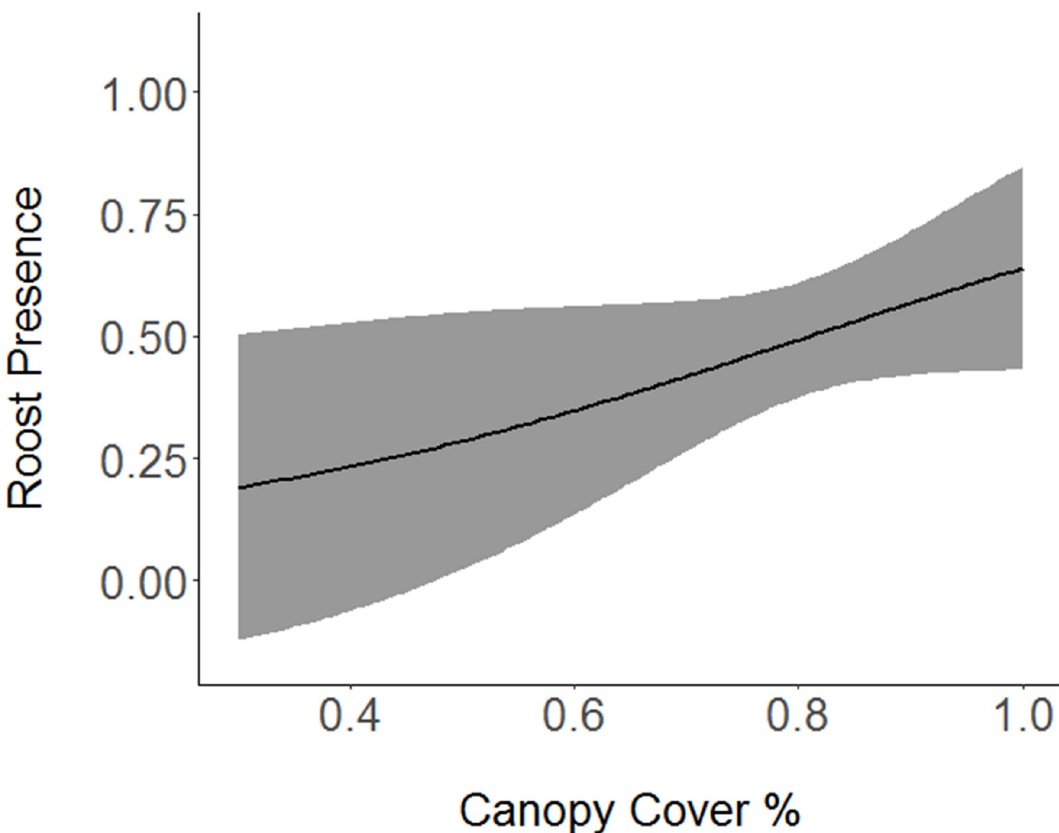
Fig 4. Association between Cerulean Warbler roosts and canopy cover. Cerulean Warbler ( Setophaga cerulea , Wilson) roost sites were positively correlated with greater canopy cover at Morgan-Monroe and Yellowwood state forests in southern Indiana, 2017. The gray area represents 95% confidence intervals. Original data are on the